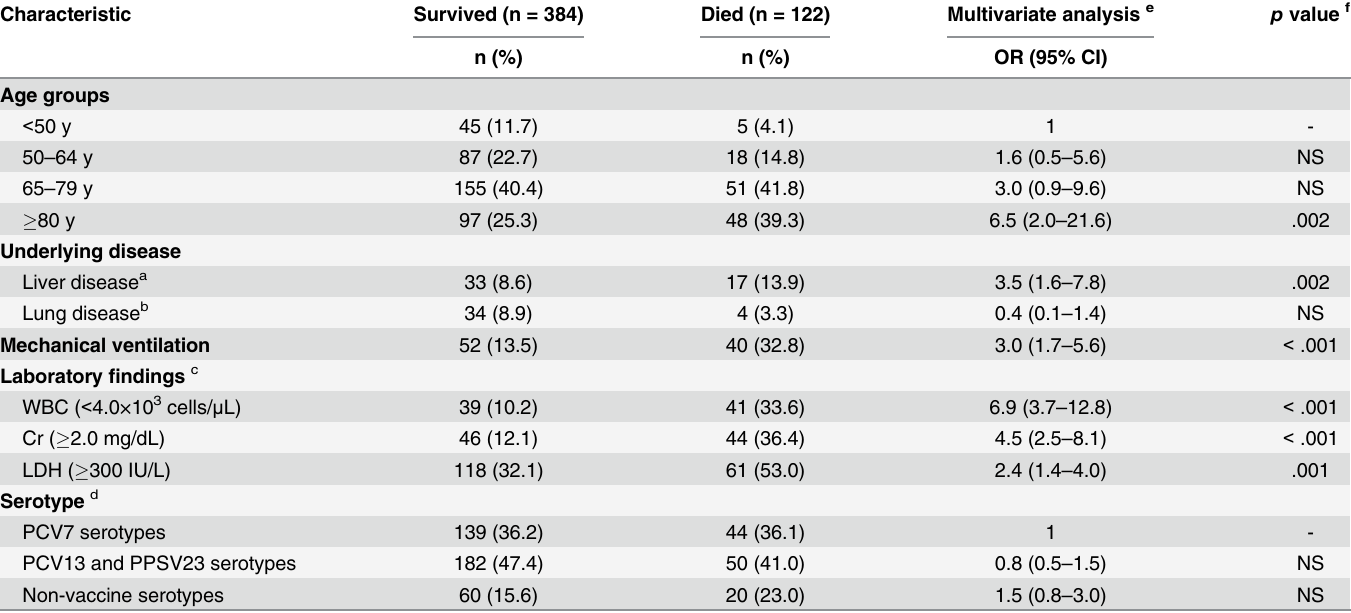
Table 3. Risk factors associated with mortality within 28 days among patients with invasive pneumococcal disease by multivariate logistic regres- sion analysis.